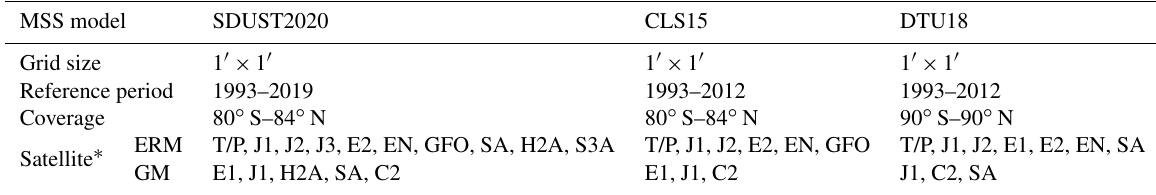
Table 4. Mean sea surface models SDUST2020, CLS15, and DTU18.